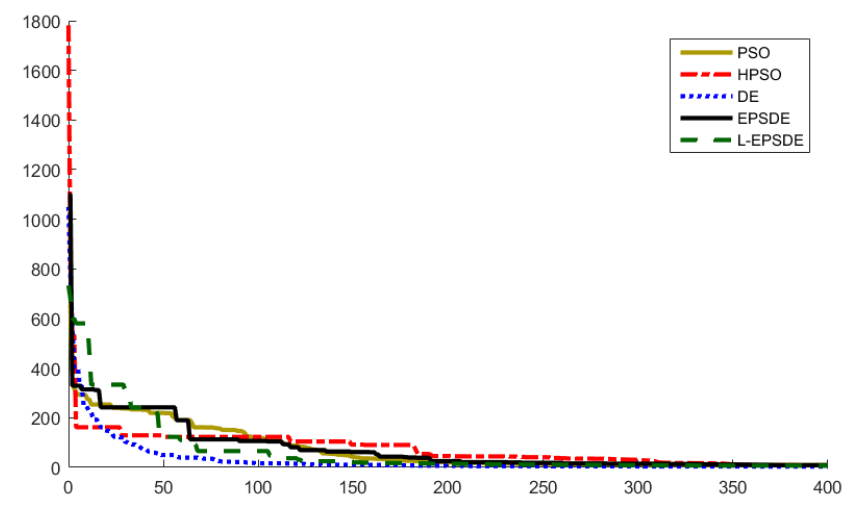
Figure 16. Convergence rate of the five metaheuristic methods for Case 3. Case 4: Straight-line segment curve (6 target points, 15 design variables)